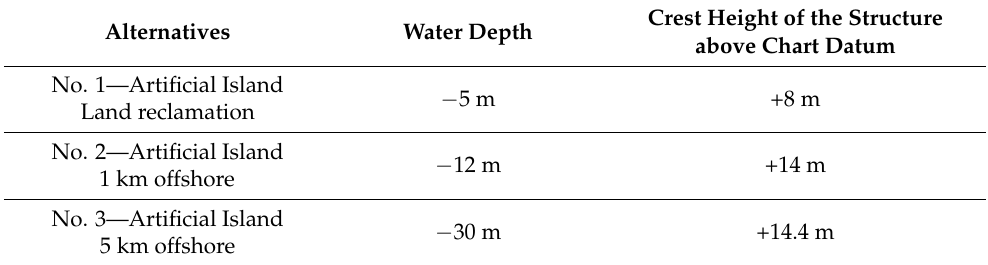
Table 1. Alternatives for marine structures for large-scale desalination plants next to Shavei